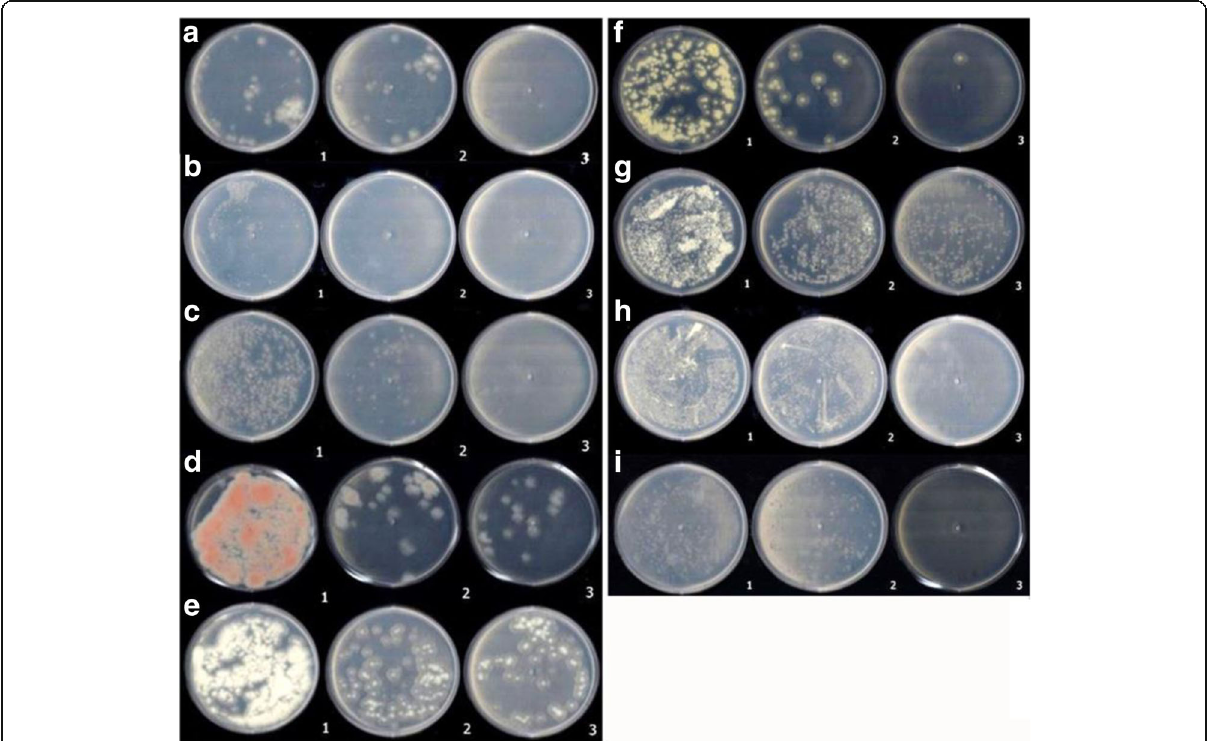
Fig. 10 Antifungal activity of different treatments, (1) control, (2) AgNO 3 , and (3) silver NPs, for different microorganisms: a Alternaria alternata , b Pyricularia grisea , c Fusarium verticillioides , d F. moniliform , e Aspergillus flavus , f A. heteromorphus , g Penicillium glabrum , h P. brevicompactum , and i Helminthosporium